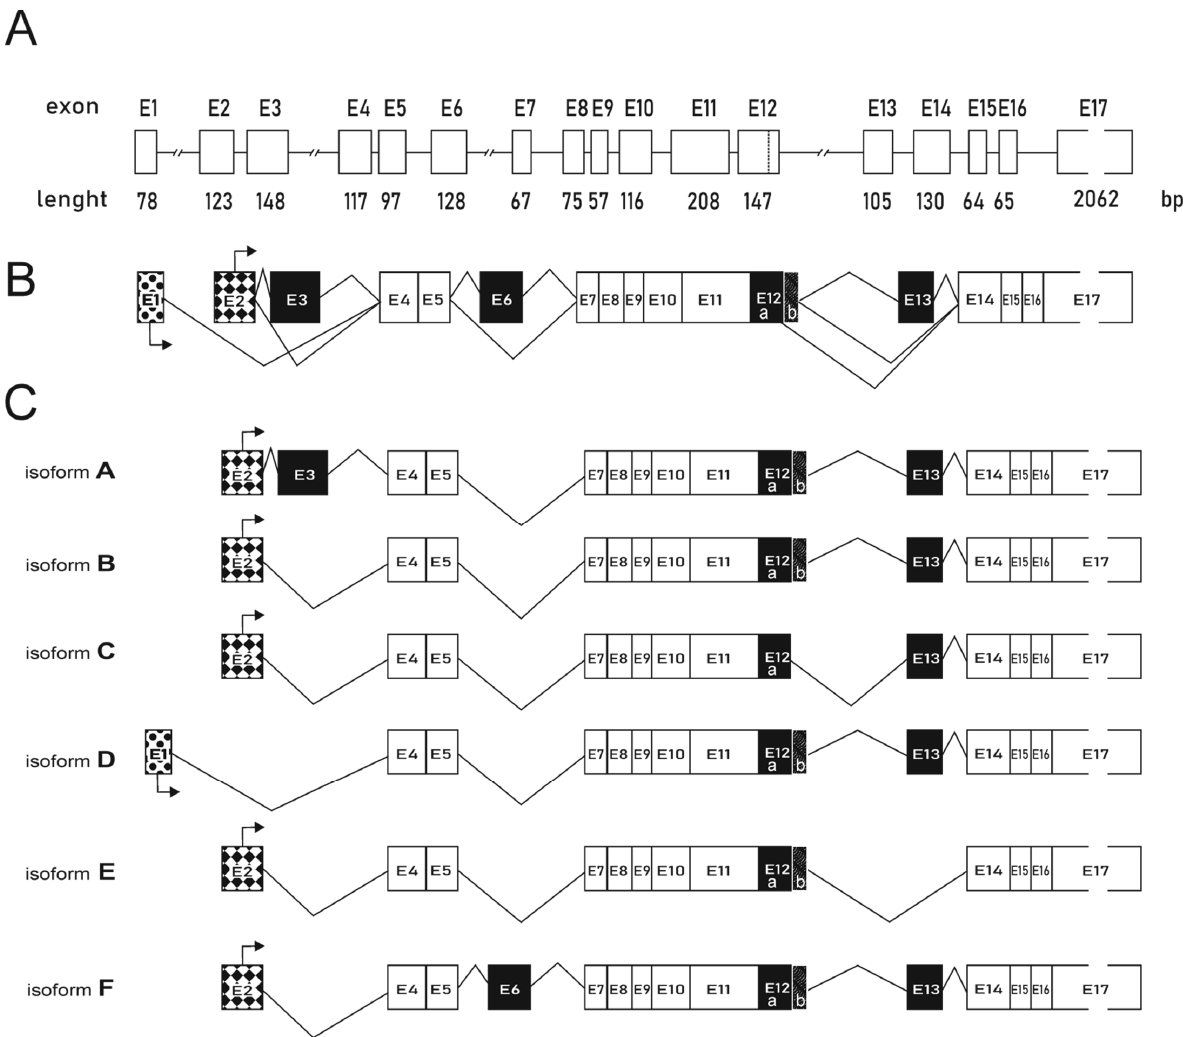
Figure 2. PFKFB4 gene structure and alternative splicing isoforms. ( A ) Schematic representation of the exon-intron organization of the PFKFB4 gene. ( B ) Alternative splicing of PFKFB4 pre-mRNA. Constitutive exons, present in all final mRNAs are shown in white. Alternative cassette exons that may be included or excluded are shown in black. Alternative promoters are patterned. ( C ) Comparison of six PFKFB4 isoforms resulting from alternative splicing. The mRNA sequences were obtained from the NCBI Gene database with the following codes: isoform A (NM_001317134.2), isoform B (NM_004567.4), isoform C (NM_001317135.2), isoform D (NM_001317136.2), isoform E (NM_001317137.2), and isoform F